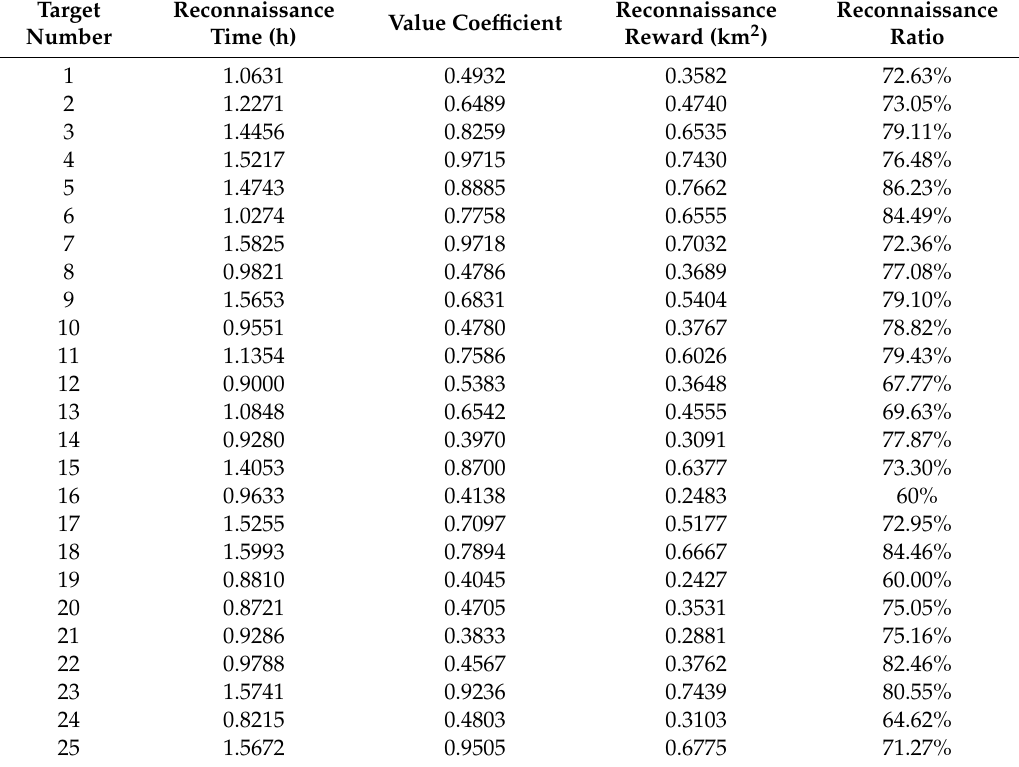
Table A3. Reconnaissance time allocation and reconnaissance reward for the target